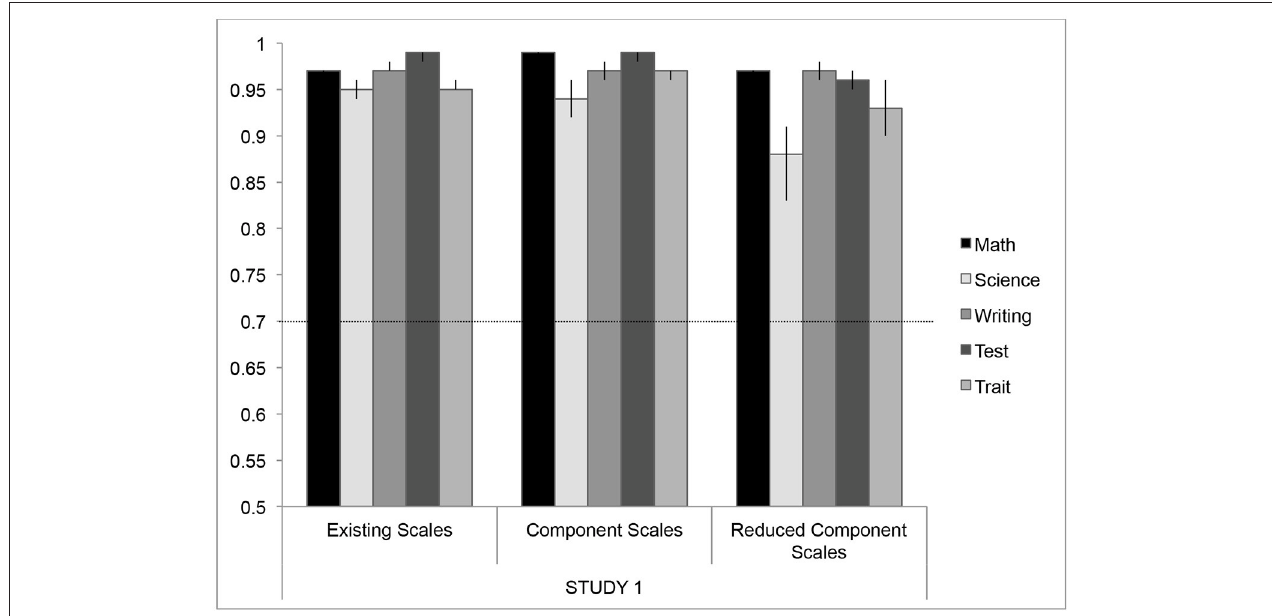
FIGURE 2 | Cronbach’s Alpha values for each domain of anxiety across different measures in test dataset ( N = 280) in Study 1. Error bars represent bootstrapped 95% confidence intervals (CIs; these error bars represent 1,000 randomized iterations of the data). Some of these 95% CIs represent values that are close to the ceiling of Cronbach’s alpha values, and so the bootstrapped CI reaches an asymptote. For some of these subscales, the 95% CIs may also be asymmetrical as the randomized bootstrapping reached lower alpha values, representing more variability in those subscales. The dashed line indicates the recommended criteria for adequate reliability using Cronbach’s Alpha (Peterson,